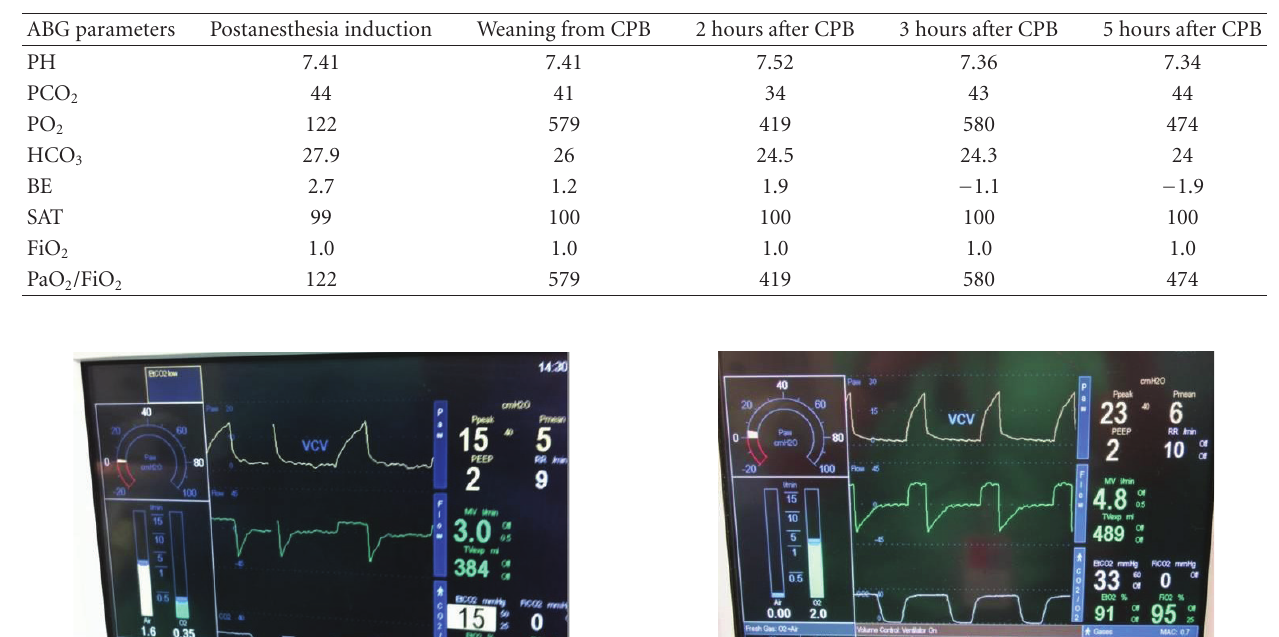
Table 1: Arterial blood gases analysis.